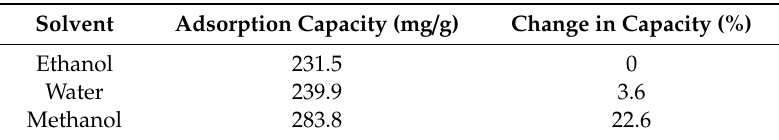
Table 3. E ff ect of the types of